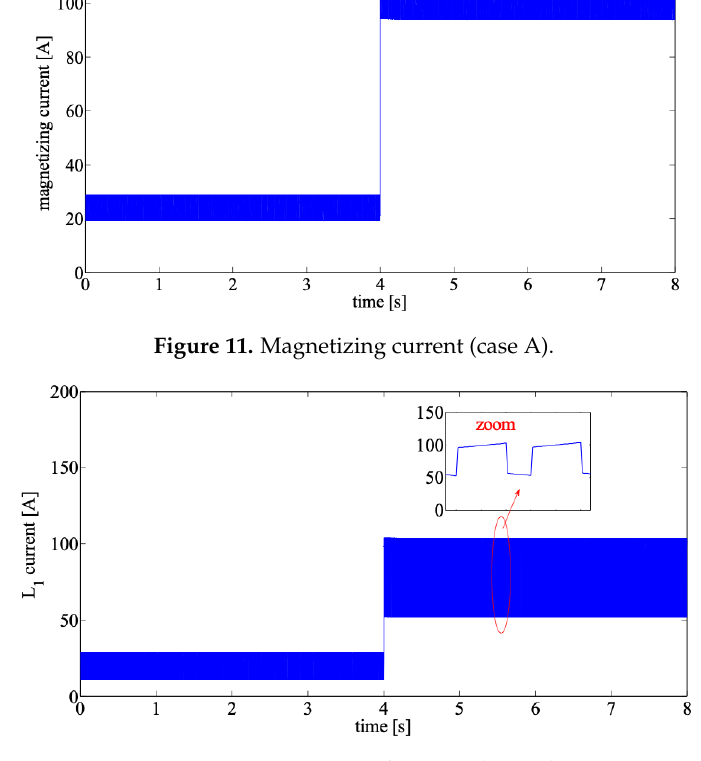
Figure 12. Current in inductor L 1 (case A).